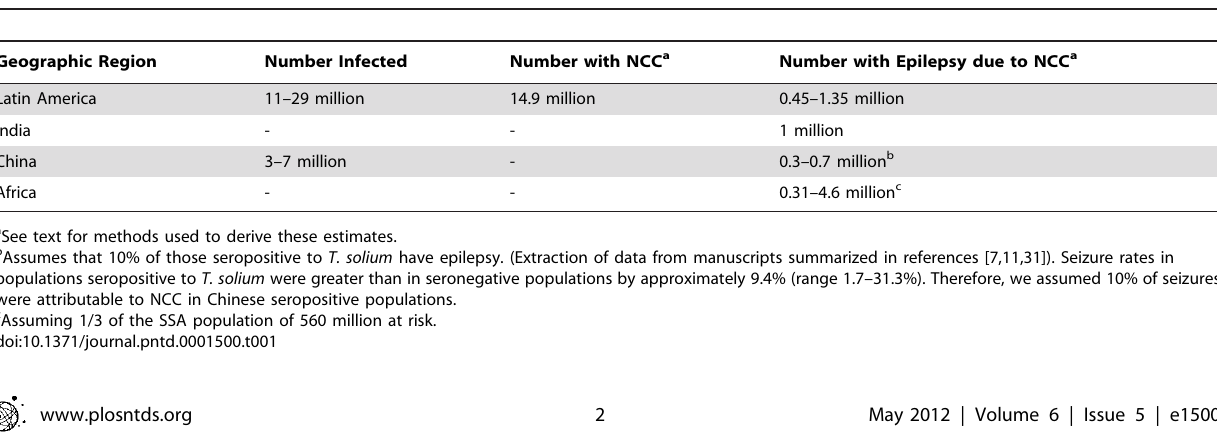
Table 1. Estimated Numbers of Persons Infected with Neurocysticercosis or Epilepsy due to Neurocysticercosis by Region.